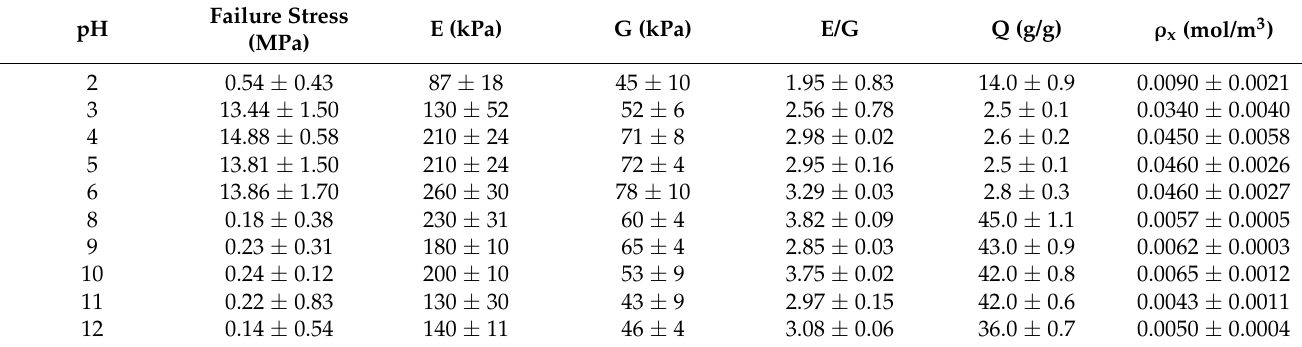
Table 2. Mechanical Properties of PVAm/PAAc